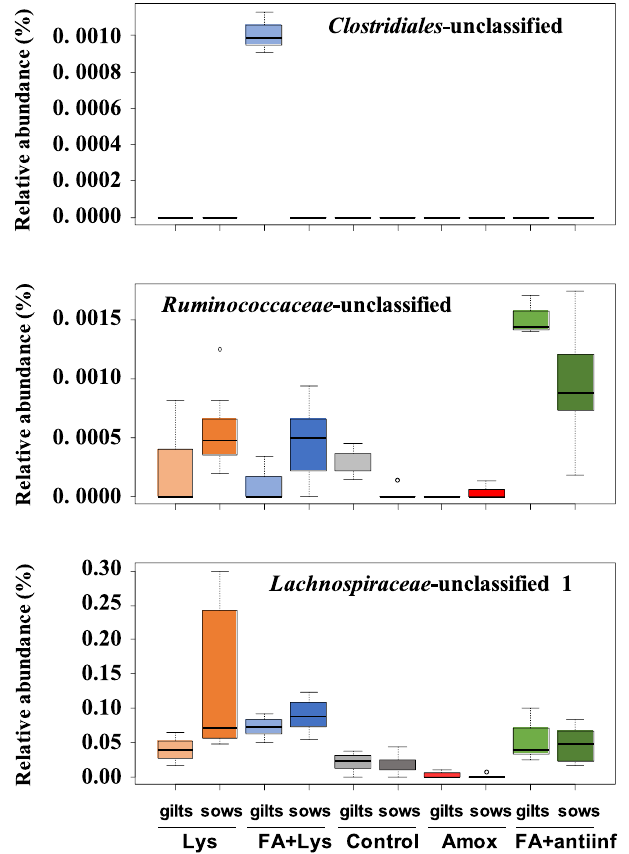
Figure 10. Analysis of composition of microbiomes (ANCOM) on nasal microbiota comparing groups considering the parity of the dams after treatment (D21). The ANCOM at amplicon sequence variant (ASV) level detected two unclassified members, one from Lachnospiraceae and other from Ruminococcaceae family, and one member from Clostridiales order as differentially abundant. The mean relative abundance of these ASVs is shown in percentage. The dotted lines represent standard deviation and outliers are indicated with white circles. The treatment groups were: Lys lysozyme, FA + lys medium chain fatty acids and lysozyme, C control, with